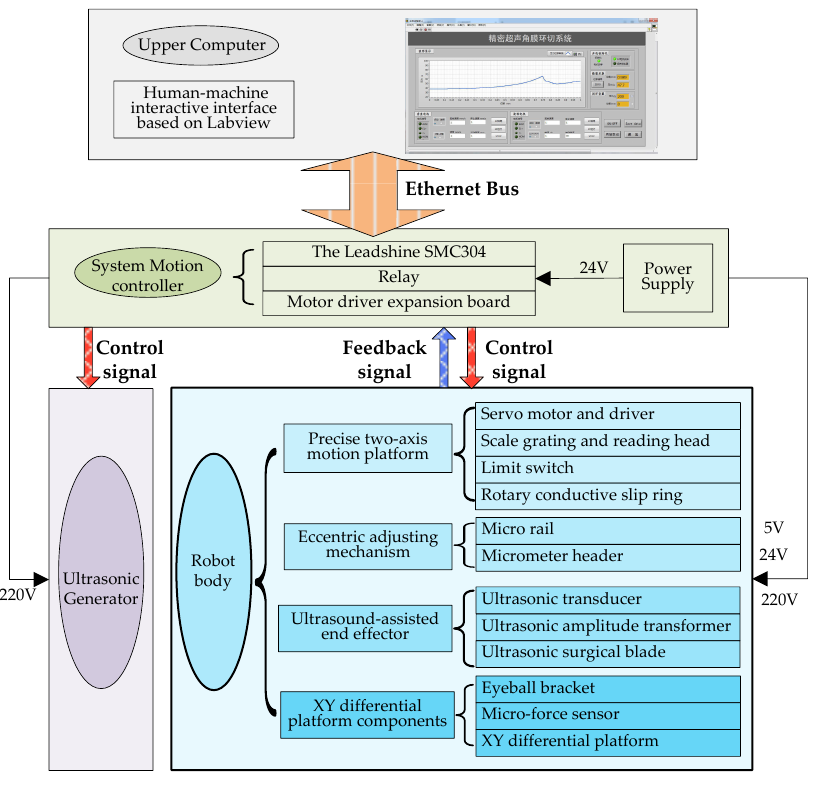
Figure 7. Overall system architecture diagram.